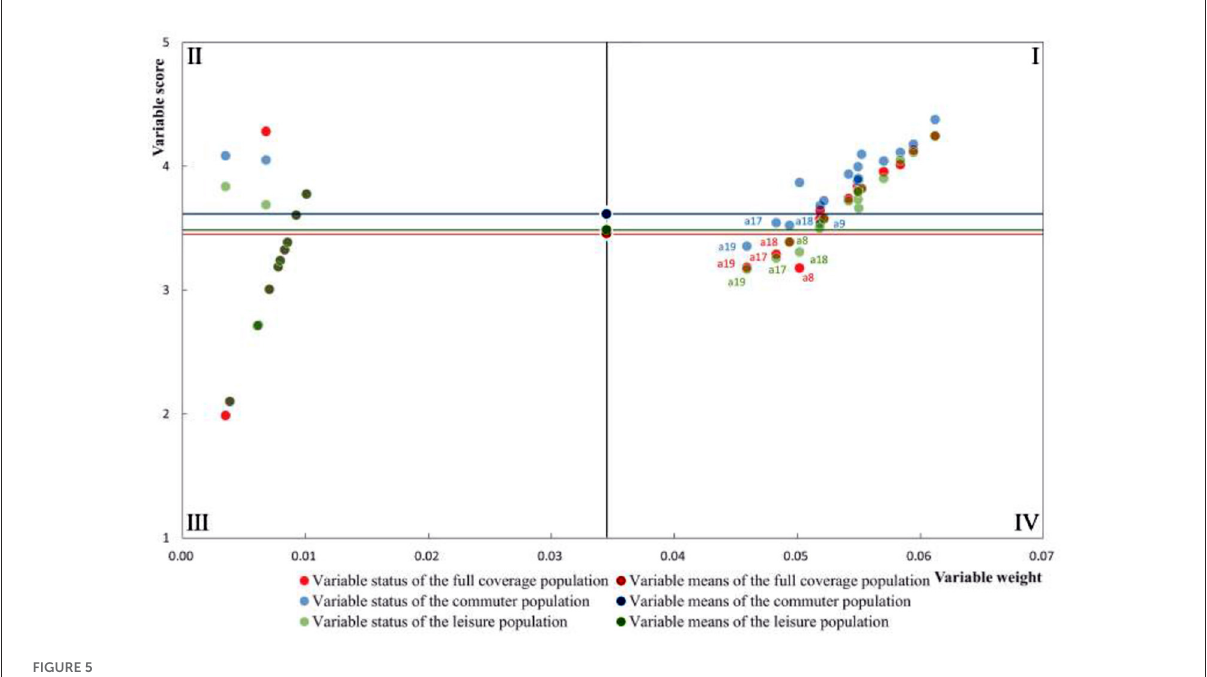
FIGURE5 “Score-effectiveness” suitability